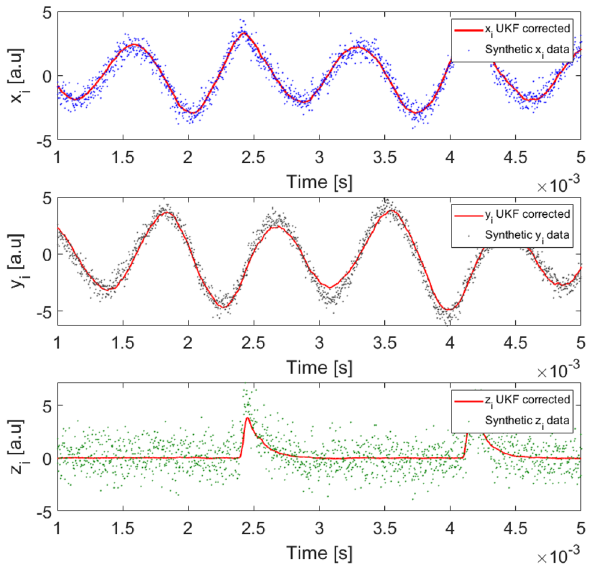
Figure 1. Raw simulated data and Kalman filter adjustment of the state variables x i ( t ) , y i ( t ) and z i ( t ) of an isolated Rössler-like oscillator. The red lines are the estimation output from the UKF algorithm observing only the time series y i . The parameters values used to generate the synthetic time series and the filtered adjustment are listed in Table 1. The points represent simulated data obtained by solving Eqs. (7a–c) and contaminated by the stochastic and noise terms (see Eqs. 3, 4). However, only the y i dataset is used as input to the UKF algorithm. The solid lines represent the values returned by the UKF